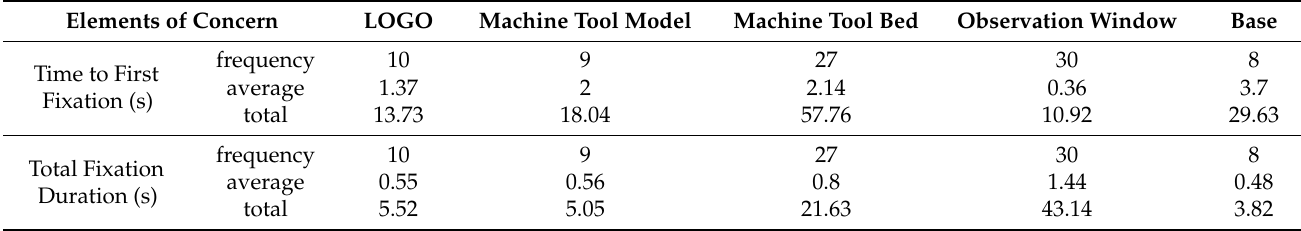
Table 3. The data on the machine tool